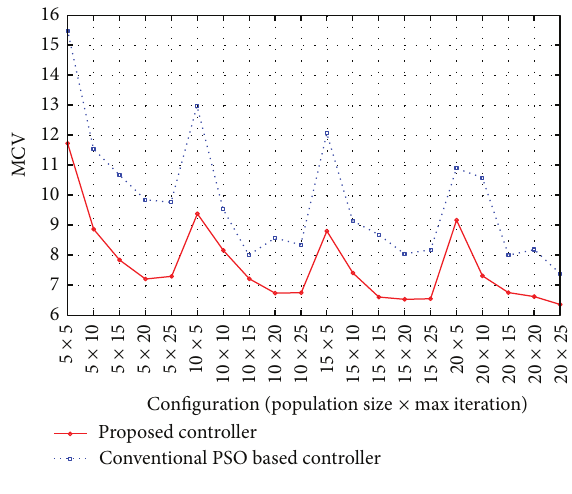
Figure 10: MCV average